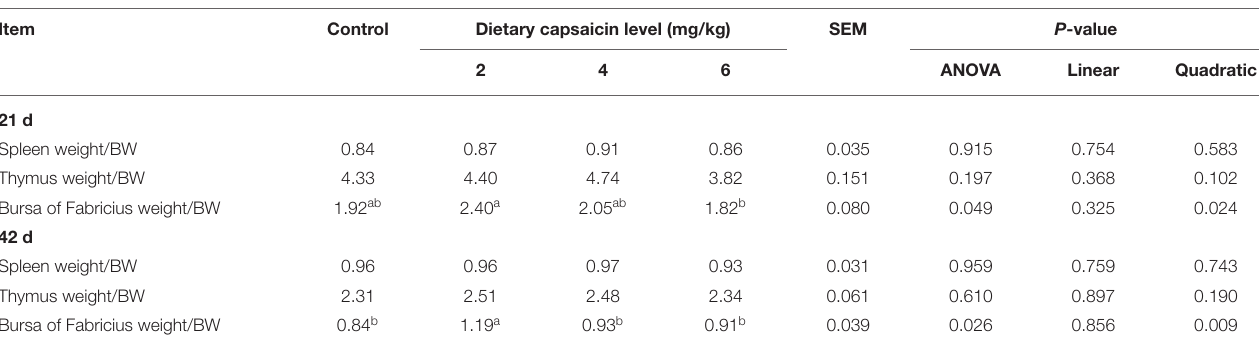
TABLE 10 | Effects of different levels of capsaicin on the immune organ indexes of broilers (g/kg). Item